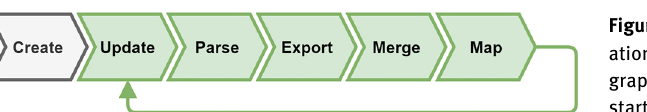
Figure 2: The program flow of BioDWH2 from the cre- ation of a workspace to the final merged and mapped